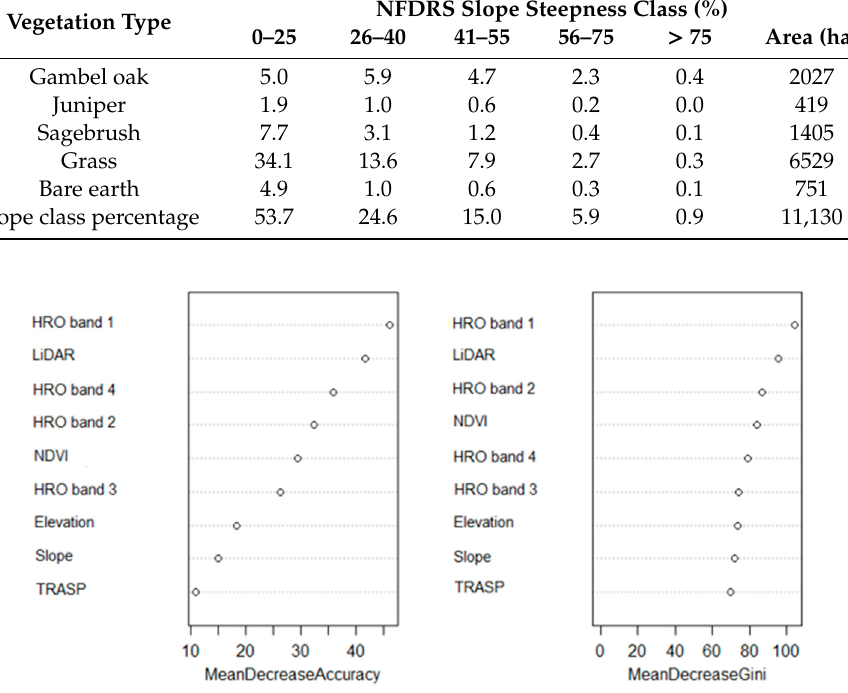
Figure 5. Mean decrease for variable importance and Gini index for the vegetation map product. LiDAR = height of vegetation from light detection and ranging values determined by taking first return values minus bare earth values, HRO band 1–4 = high resolution orthoimagery taken from bands 1–4, respectively. NDVI = normalized difference vegetation index and TRASP = transformed aspect.